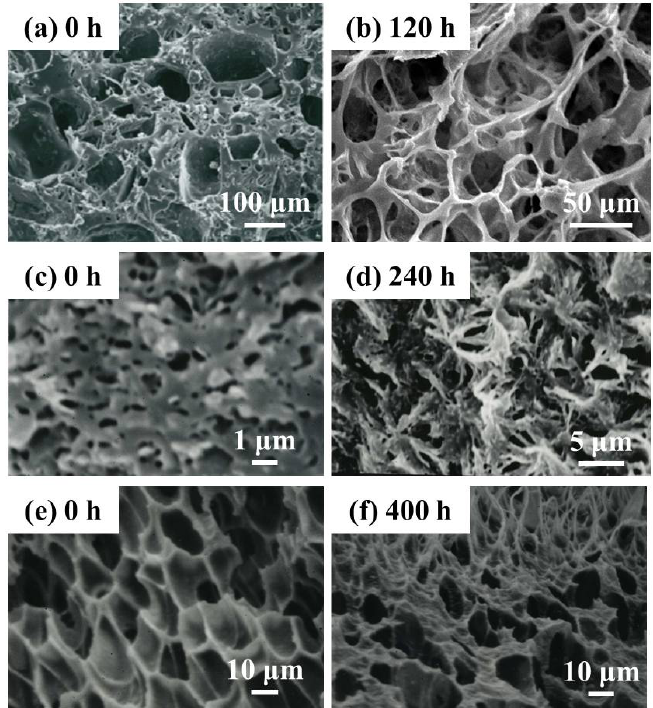
Figure 12. Typical SEM images of the cross section of Lait-X having porous structure ( a , b ), linear PLA having nanoporous structure ( c , d ) and linear PLA having microporous structure ( e , f ) before and after degradation for different time